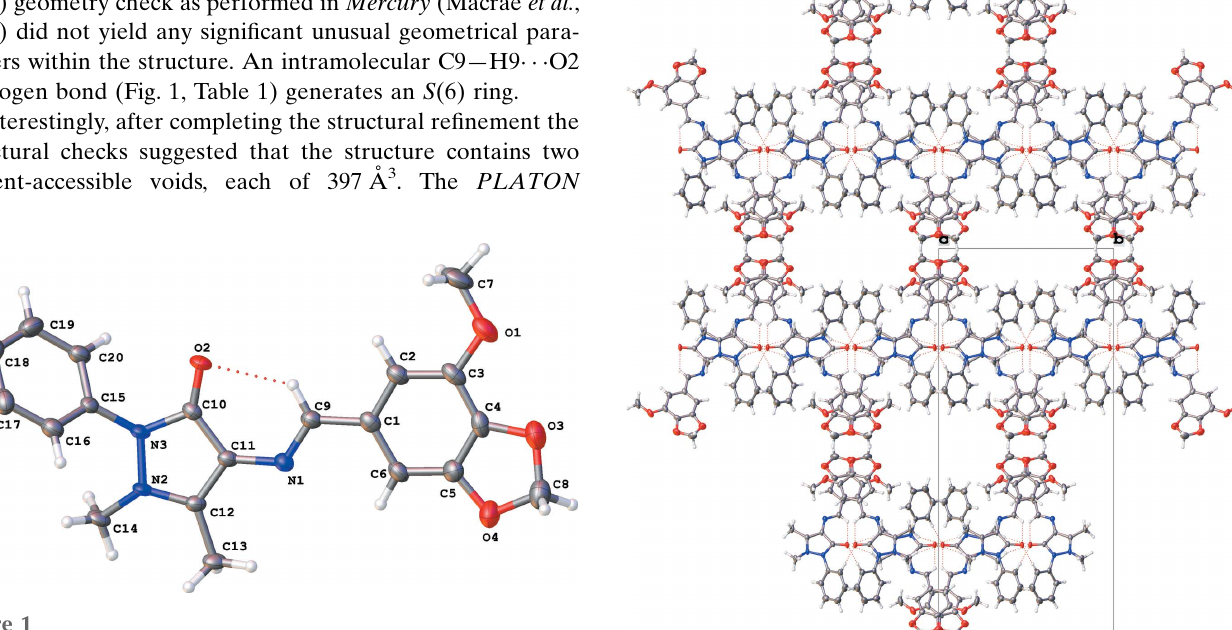
Figure 1 The molecular structure of I , showing the atom-labelling scheme. Displacement ellipsoids are drawn at the 50% probability level. Dashed red lines indicate hydrogen-bonding interactions.